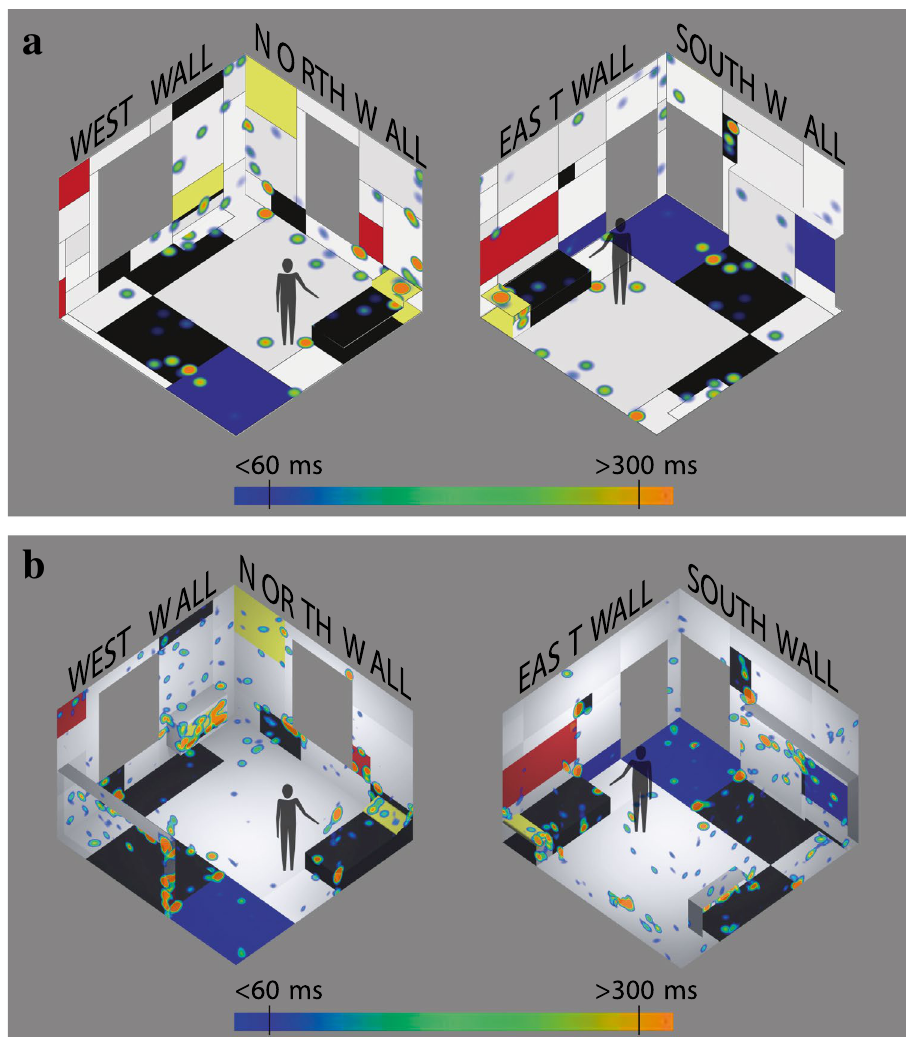
Figure 3. Exemplar fixation duration heatmap from a single participant. ( a ) Heatmap corresponding to the physical condition was formed after 89 s of interaction inside the physical installation, and ( b ) the heatmap corresponding to the VR condition was formed after 162 s of interaction inside the virtual environment. The colour-coded scale ranging from blue to orange approximately corresponds to fixation duration ranging from 60 to 300